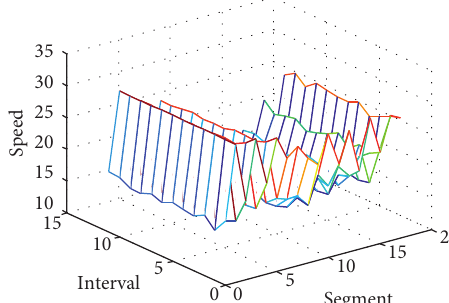
Figure 15: The speed distribution with VSL.